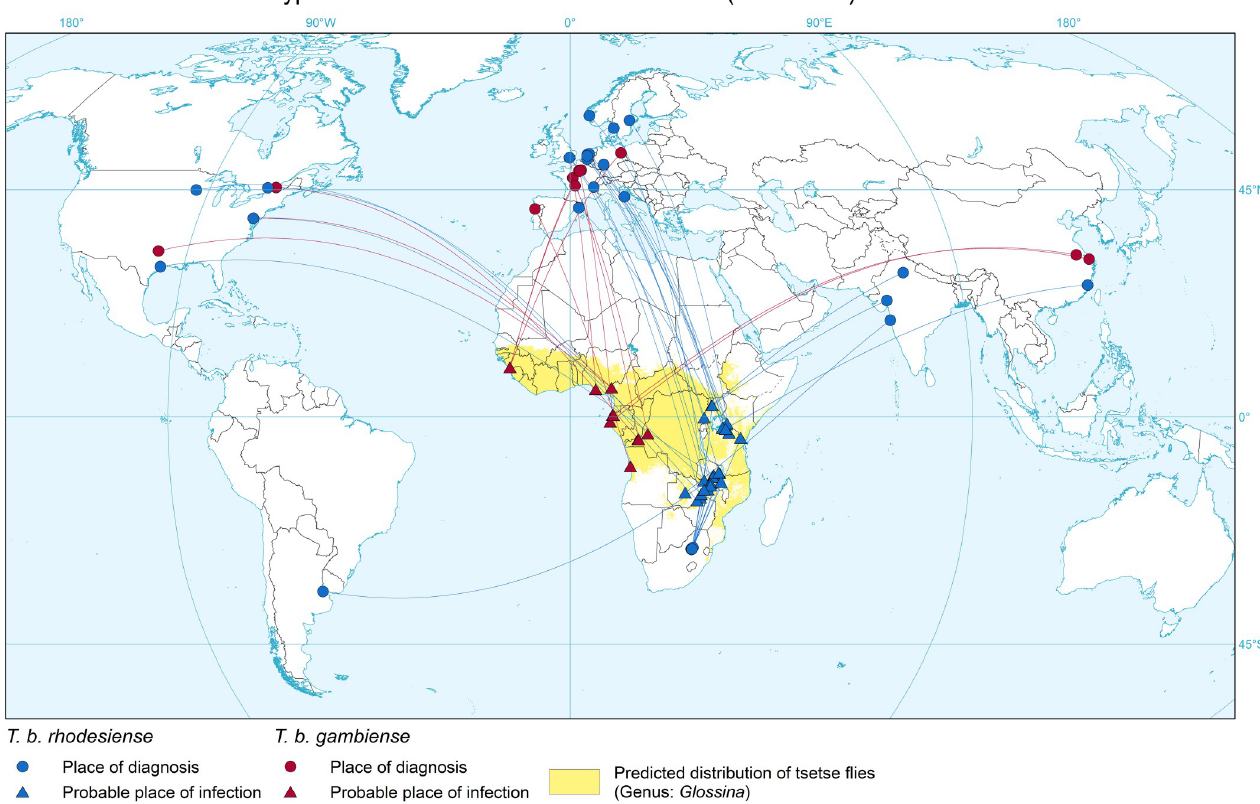
Fig 2. Cases of HAT diagnosed in non-DEC. 2011–2020. Circles represent the place of diagnosis; triangles indicate the probable place of infection. Gambiense HAT (red), rhodesiense HAT (blue). The base layers used in this map are the FAO Global Administrative Unit Layers (GAUL)